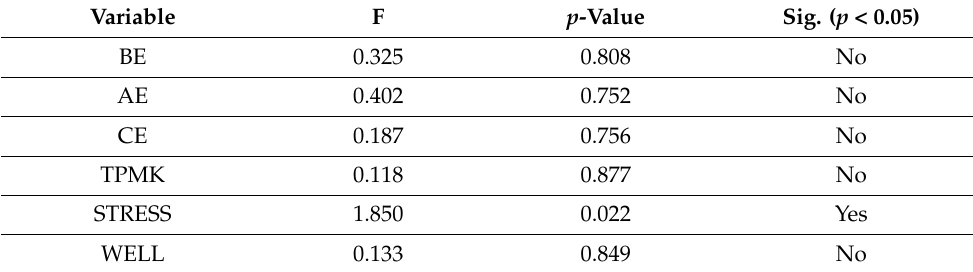
Table 7. The t-test results of the gender factor on the engagement level, stress, well-being, and TPMK. Variable F p -Value Sig. ( p < 0.05) BE 5.181 0.240 No AE 1.042 0.308 No CE 2.927 0.089 No TPMK 0.857 0.356 No STRESS 8.004 0.005 Yes WELL 0.394 0.555 No